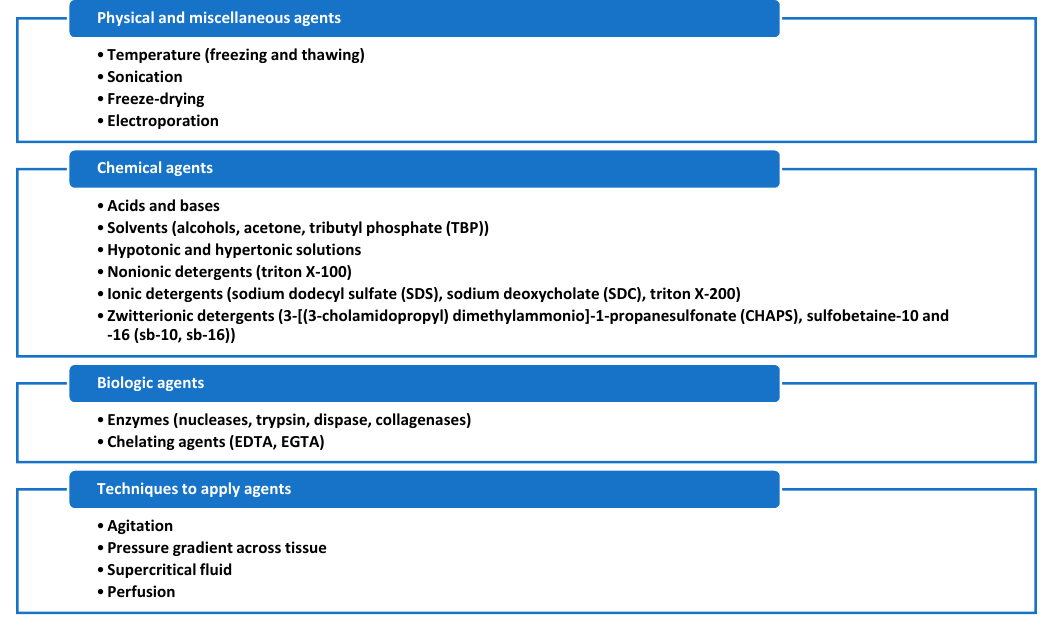
ff erent decellularization agents and techniques Figure 5. Summary of the different decellularization agents and techniques [69–71]. Figure 5. Summary of the di